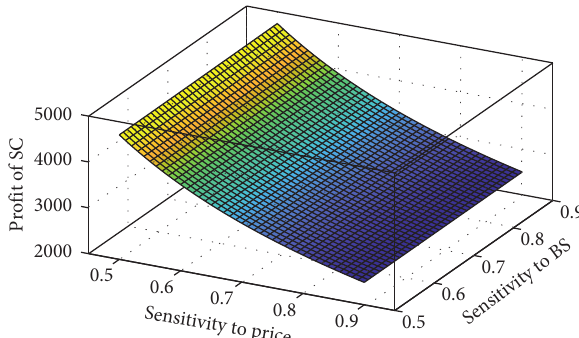
Figure 2: The effects of consumers’ sensitivity b and β on SC profit.